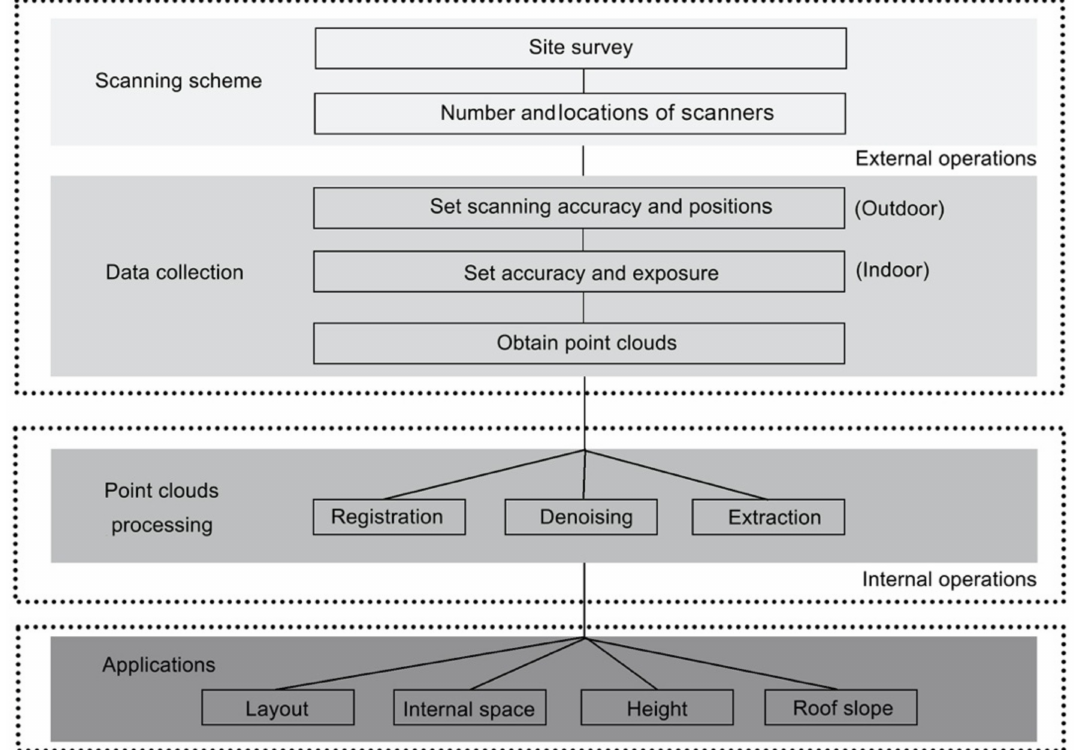
Figure 2. Research process. Four main steps included in this research, including designing the scanning schema, data collection, point clouds processing, and model